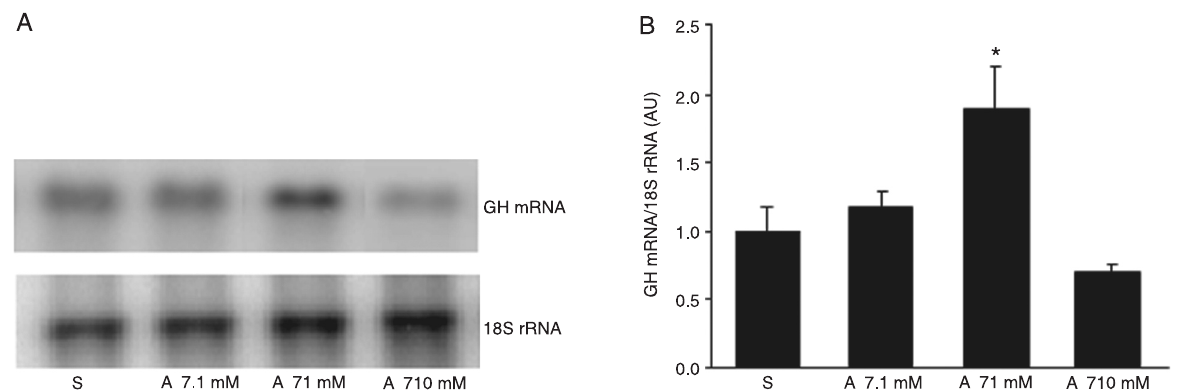
Figure 1. Dose-response study of the effect of arginine on growth hormone (GH) mRNA expression. A , Typical autoradiograms of the GH mRNA and 18S abundance obtained in one experiment of a total of three. B , Quantitative representation of hybridization of GH and 18S rRNA transcripts obtained in all experiments. Hemi-pituitaries were incubated for 1 h with saline (S) or arginine (A) at the concentrations of 7.1, 71, and 710 mM. The values obtained from blot densitometry were normalized by 18S rRNA. Data are reported as means ± SEM in arbitrary units (AU). *P < 0.01 vs all other groups (one-way ANOVA followed by the Student-Newman- Keuls